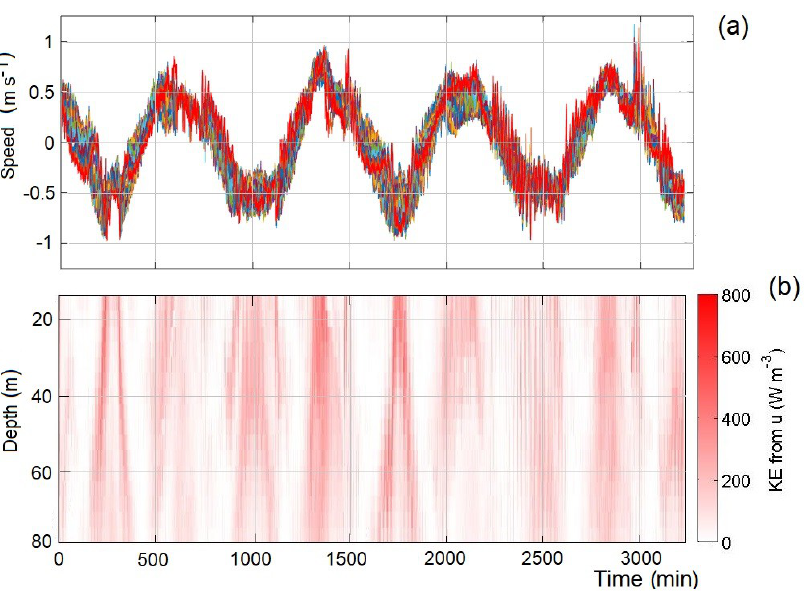
Figure 9. ( a ) u-component of the current velocity at 17 ADCP depths. ( b ) Total kinetic energy of the Figure 9. (a) u‐component of the current velocity at 17 ADСP depths. (b) Total kinetic flow in this layer of energy of the flow in this layer of water.